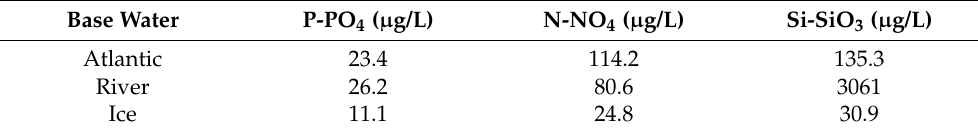
Table 1. Values of the studied parameters ( Caj , Crj , Cij ) in the initial water